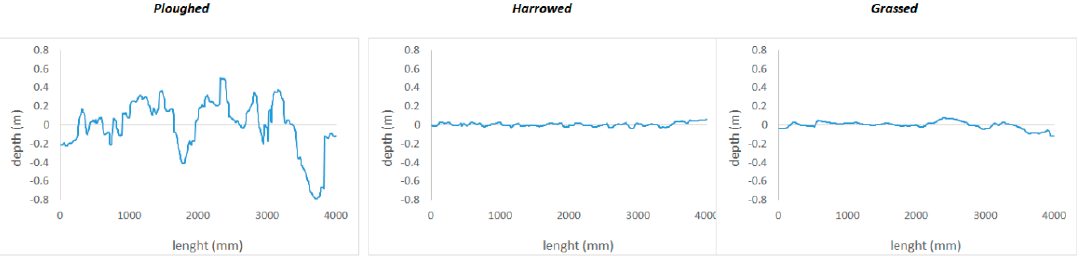
Figure 5. Profiles values extracted with the light drone converted to metric scale of the 3 types of soil (ploughed, harrowed and grassed).